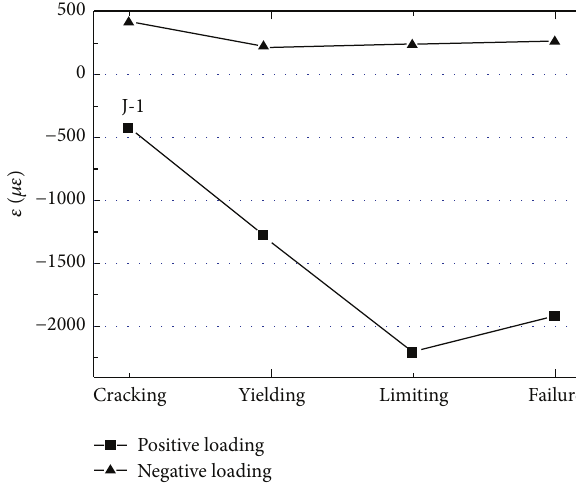
Figure 14: Strain of beam steel flange.